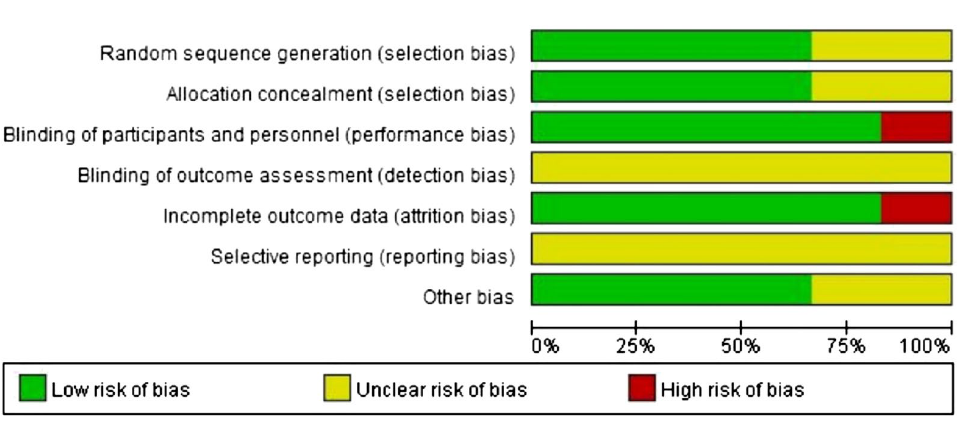
Figure 3. Graphs of risk of bias for